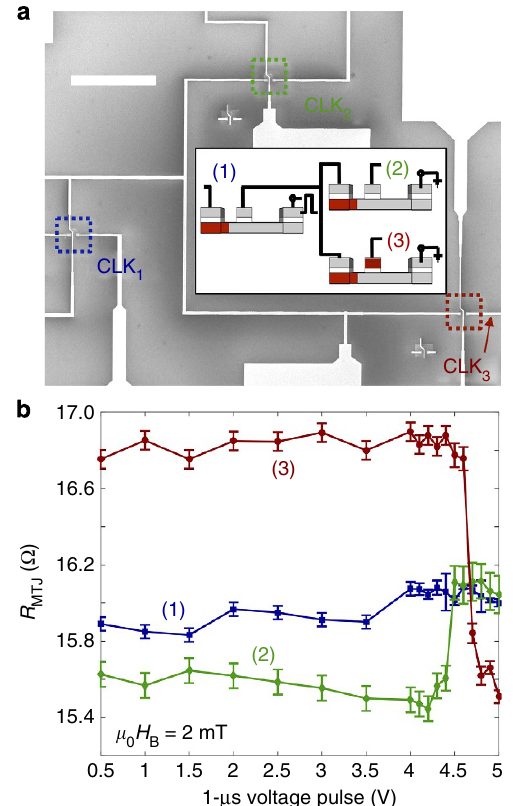
Figure 4 | Concatenation. ( a ) SEM image of one device output connecting to the inputs of two devices. Voltage pulses are applied to CLK 1 with CLK 2 and CLK 3 grounded. Scale bar, 100 m m. (inset) Cartoon of the initial configurations of the three devices, with the DWs initialized on the left. Red signifies magnetized right and grey signifies magnetized left. ( b ), Plot of MTJ resistance versus pulsed voltage applied at CLK 1 , showing one device can power a switch in two subsequent devices. Here, the error bars represent the average noise fluctuation in R monitored for each device at each voltage